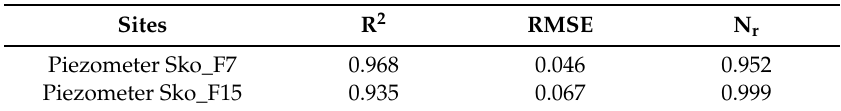
Figure 7. Correlation between observed and simulated groundwater levels in meters above mean sea level (mamsl) at ( a ) piezometer F7 and ( b ) piezometer F15. Table 2. EARTH model performance evaluation (R 2 : Correlation coefficient; RMSE: Root mean square error; N r : Nash-Sutcliffe efficiency).